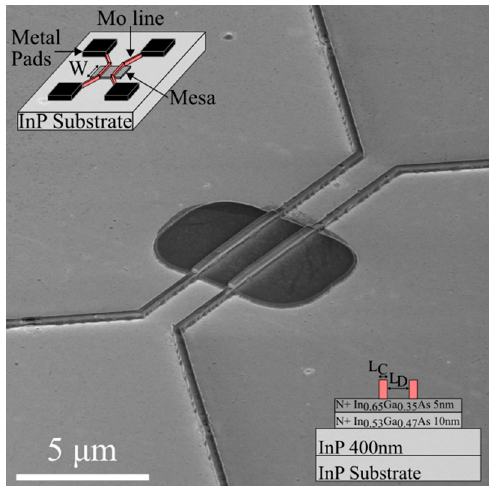
Figure 1. SEM image of the Transmission-Line-Model (TLM) device. The inserts represent the TLM structure scheme ( top ) and the cross-section showing different layers of the active area ( bottom ).